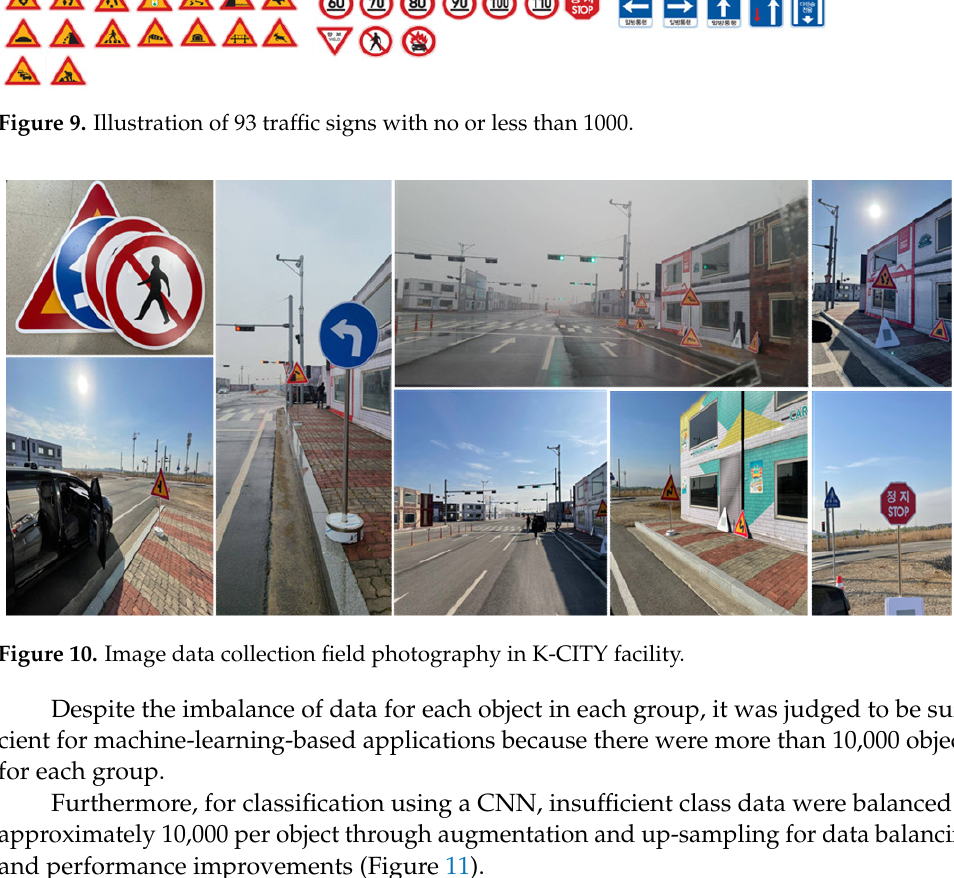
Figure 9. Illustration of 93 traffic signs with no or less than 1000.